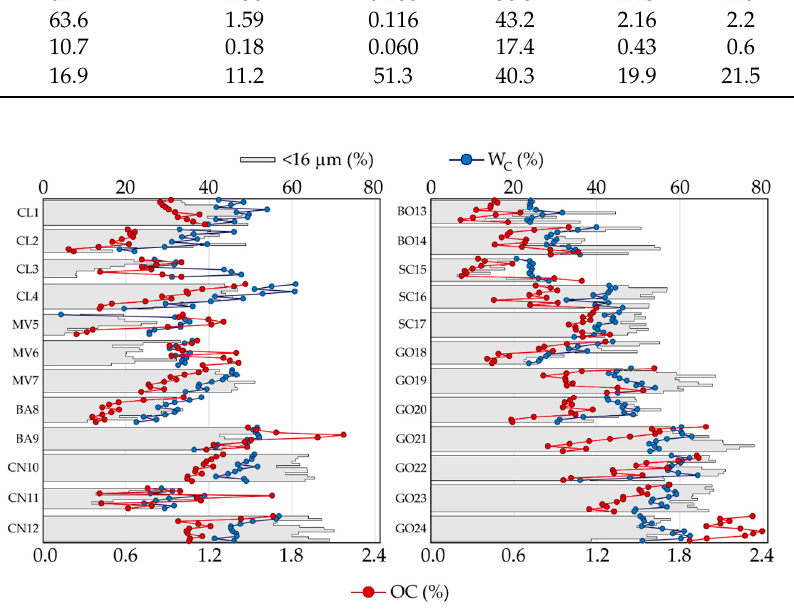
Figure 3. Percentages of water content, fine particles and organic carbon in the 252 sediment layers analysed in the 24 cores. For each core, the sequence of investigated layers with depth is shown from left to right.